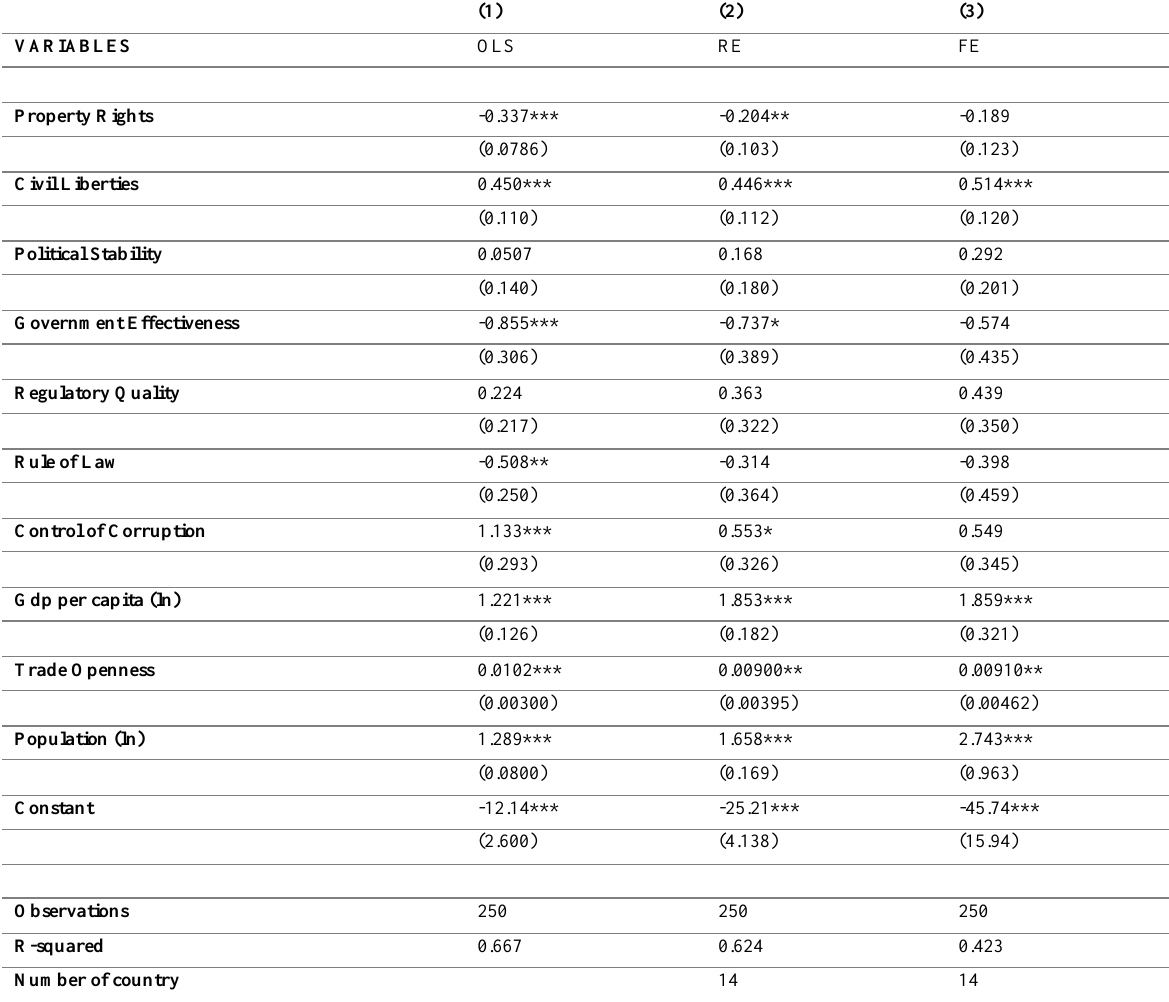
Table 3: Regression Results (All 13 Emerging